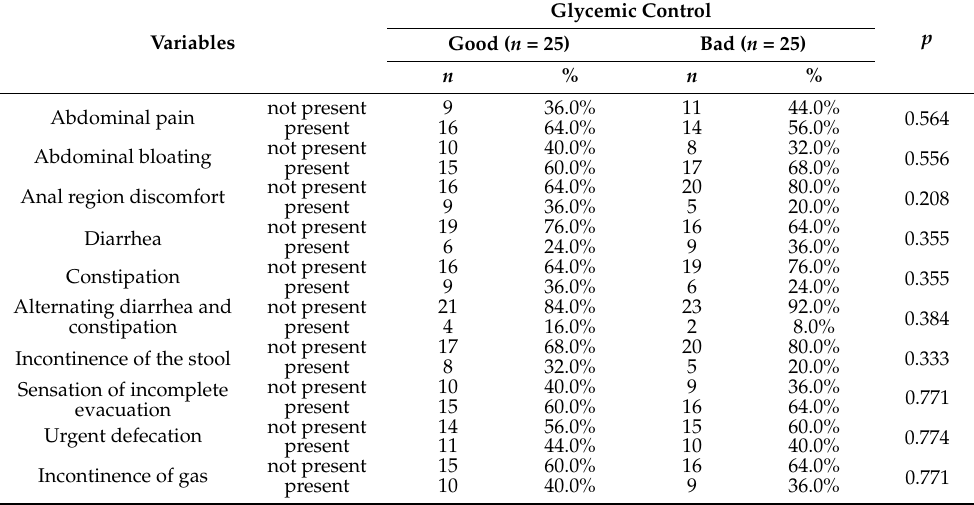
Table 5. The frequency of gastrointestinal symptoms in diabetic patients depending on glycemic